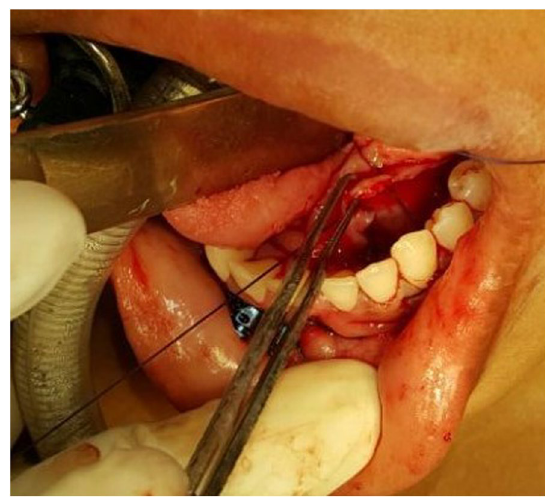
Fig. 3 Intra-oral transcrevicular incision placed in the region of canine-premolar, taking care not to injure the Wharton’s duct and without violating the floor of the